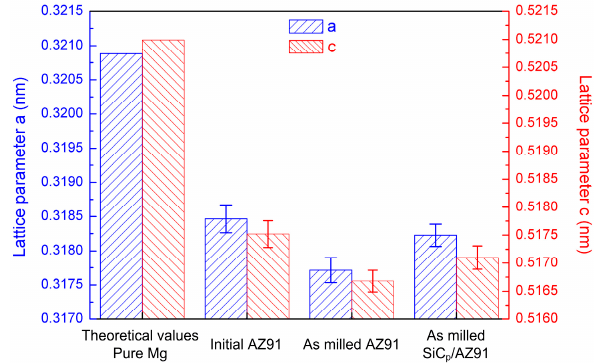
Figure 8. The lattice parameters of magnesium matrix with various states.